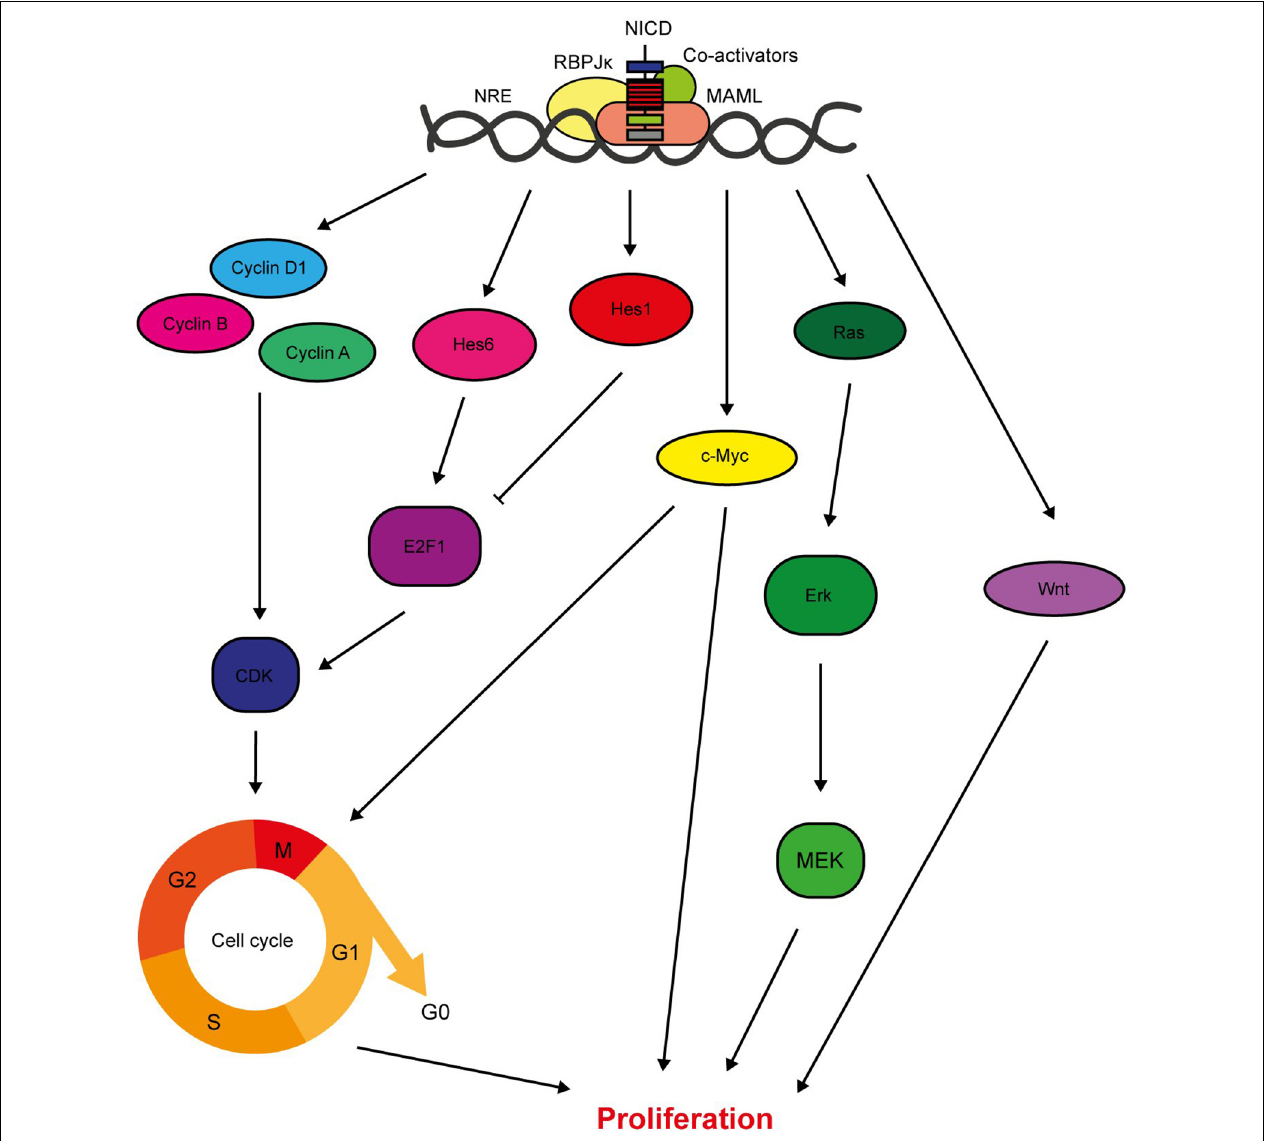
FIGURE 3 | Notch regulates breast cancer cell proliferation. Notch signalling has several direct target genes implicated in cell cycle regulation. These include cyclins A, B and D1, and Hes/Hey family members (Rizzo et al., 2008; Cohen et al., 2010). While most factors downstream of Notch increase the proliferative rate of the cell, Hes1 downregulates E2F1 expression which inhibits cell cycle progression (Hartman et al., 2009; Strom et al., 2009). Notch also activates key oncogenic signalling pathways with pleiotropic effects on cellular function including proliferation, such as c-Myc, Ras and Wnt (Mittal et al., 2009; Aster et al., 2017; Lai et al.,